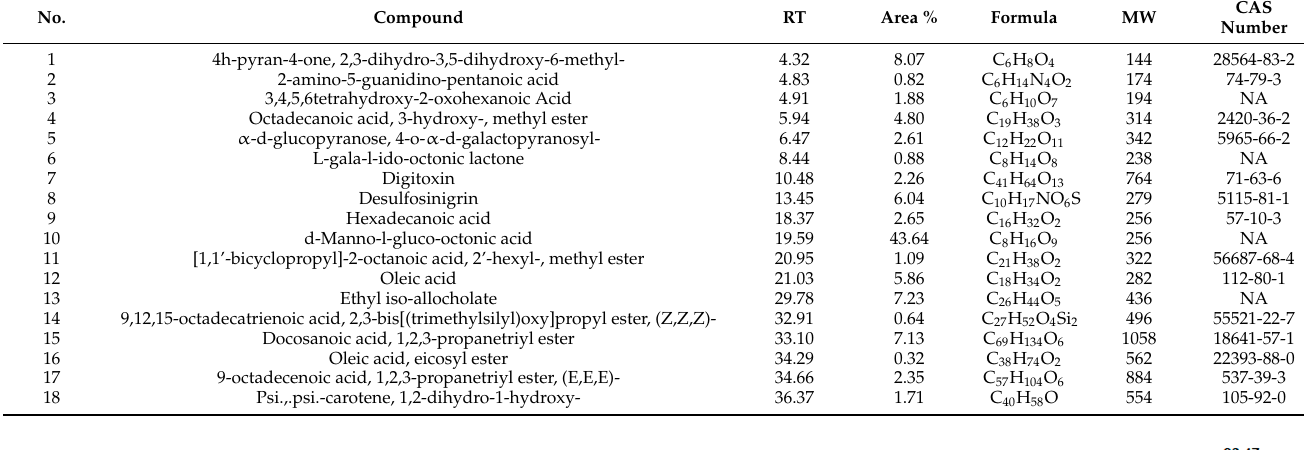
Figure 1. GC–MS chromatogram of methanolic fruit mesocarp extract of neem. Table 3. Chemical composition of methanolic fruit epicarp extract of neem screened by GC–MS.